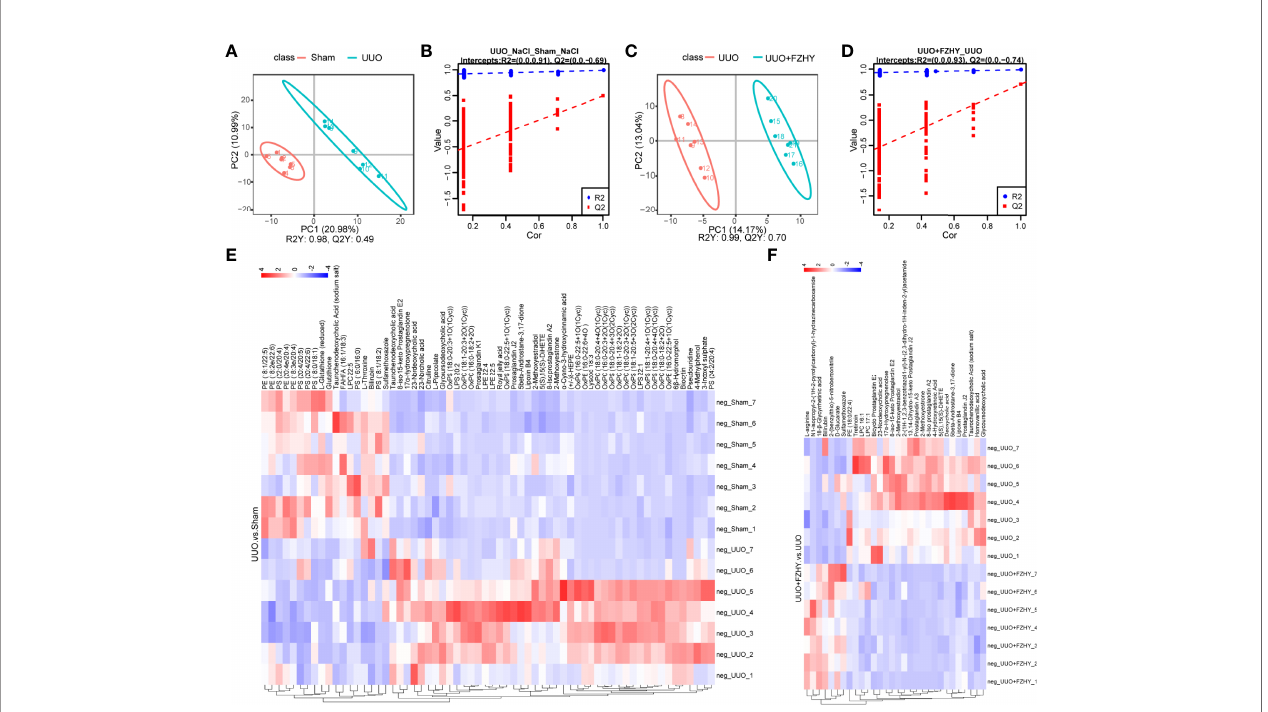
FIGURE 4 | Metabolomics analysis of cationic metabolites. PLS-DA score plots for the comparison of the global metabolite pro fi les in the UUO and sham groups (A) and the UUO+FZHY and UUO groups (C) . Validation plot by permutation test for the UUO and sham groups (B) and the UUO+FZHY and UUO groups (D) ; the abscissa represents the correlation between the Y of the random grouping and the original group Y, and the ordinate represents the scores of R2 and Q2. R2Y represents the interpretation rate of the model, Q2Y is used to evaluate the predictive ability of the PLS-DA model, and a higher R2Y value in a PLS-DA model indicates a better model fi t. The heatmap plot for metabolites between the UUO vs. sham groups (E) and the UUO+FZHY vs. UUO groups (F)